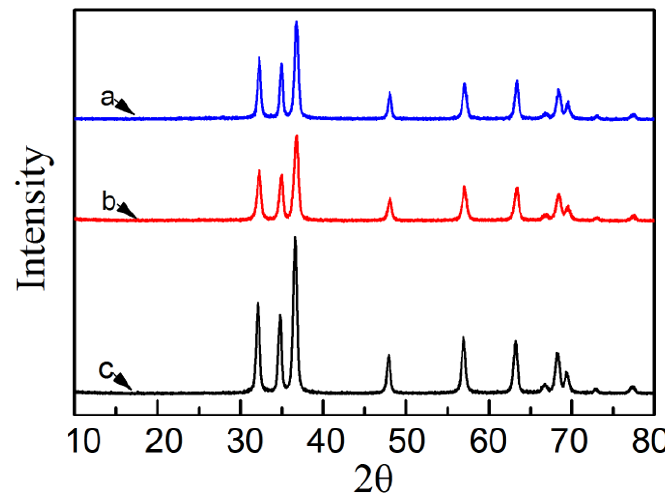
Figure 1. XRD spectra of ( a ) zinc oxide (ZnO), ( b ) polydopamine/ZnO (PDA/ZnO), and ( c ) dimercaptosuccinic acid/Polydopamine/zinc oxide (DMSA/PDA/ZnO).